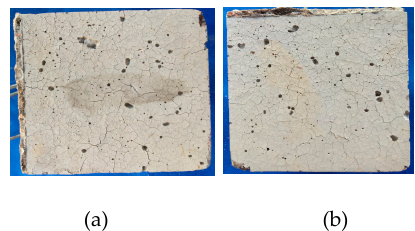
Figure 17. The final state of the PVA fiber specimens with different heat rates: ( a ) A heat rate of 3 °C/min and ( b ) a heat rate of 5 °C/min.